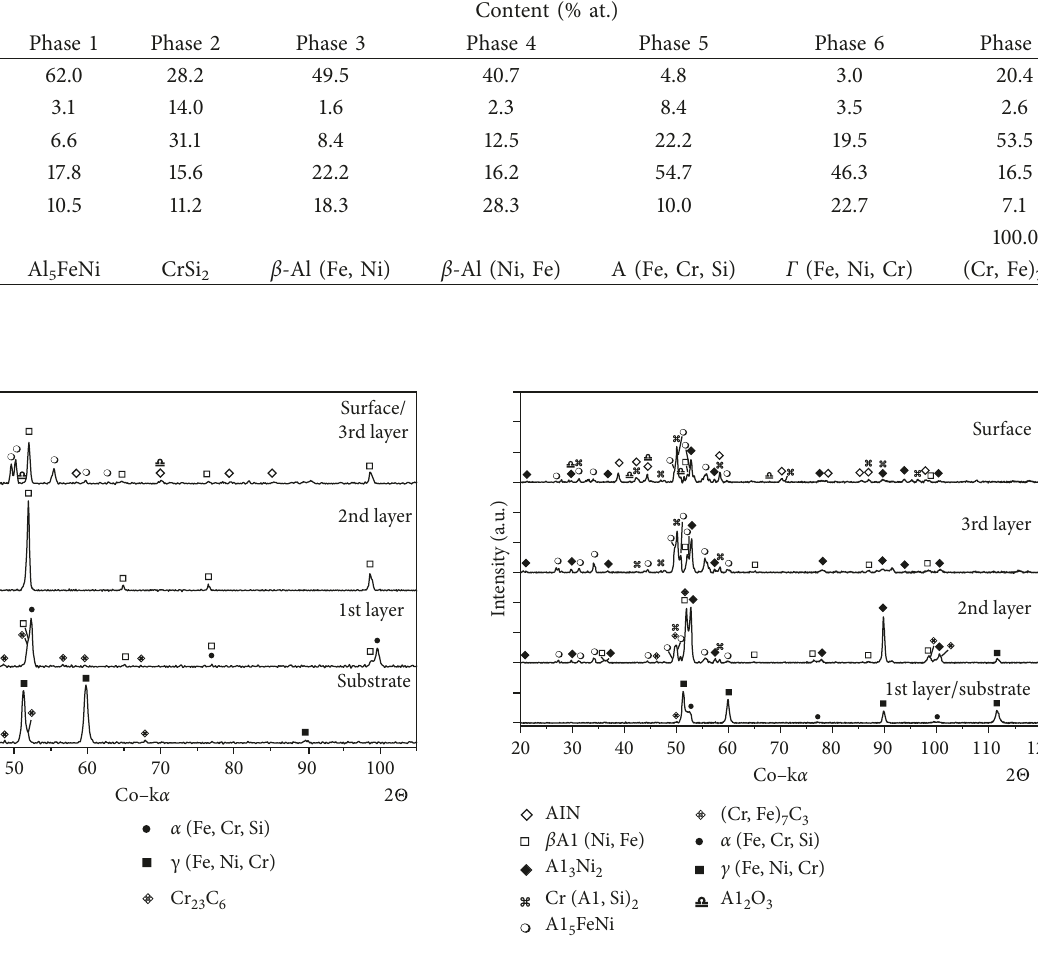
Figure 9: XRD patterns (the coating number 3 obtained at 800 ° C, 10 hours, Al/Si (cid:31)